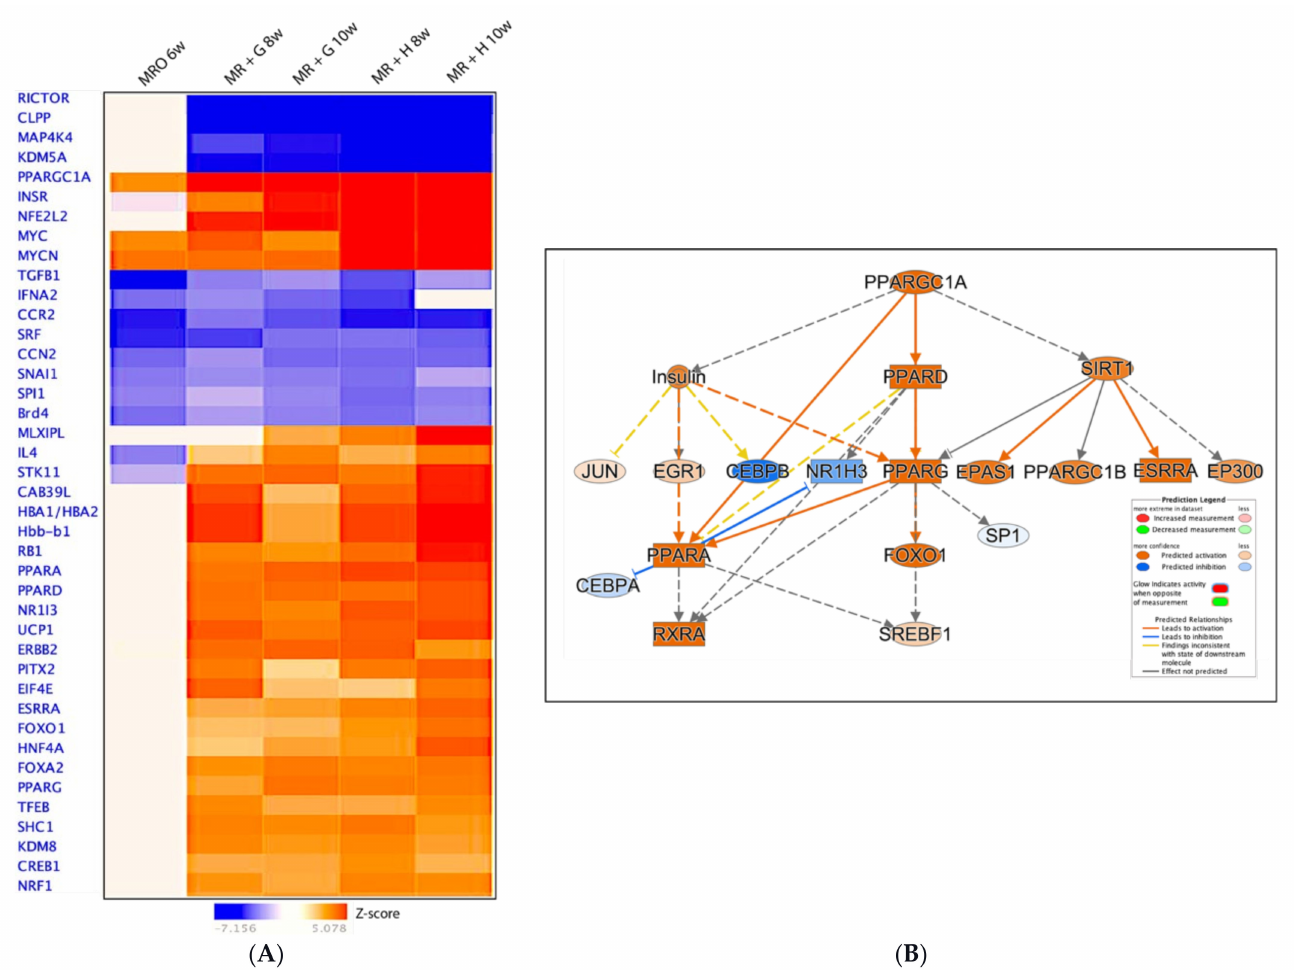
Figure 6. ( A ) Comparison analysis-the upstream regulators: Clusters of effectors on the key pathways to control the patterns of ruminal functions. Upstream regulator analysis showed activation of many upstream regulators and transcription factors during the transition of weaning. ( B ) Predicted mechanistic network of the upstream regulator PPARGC1A: The mechanistic network contains 19 regulators in the dataset (and 462 downstream genes, See Supplemental Table S1). The entries in Supplemental Table S1 show how a target (row) supports the prediction of a regulator (in each column) in the PPARGC1A mechanistic